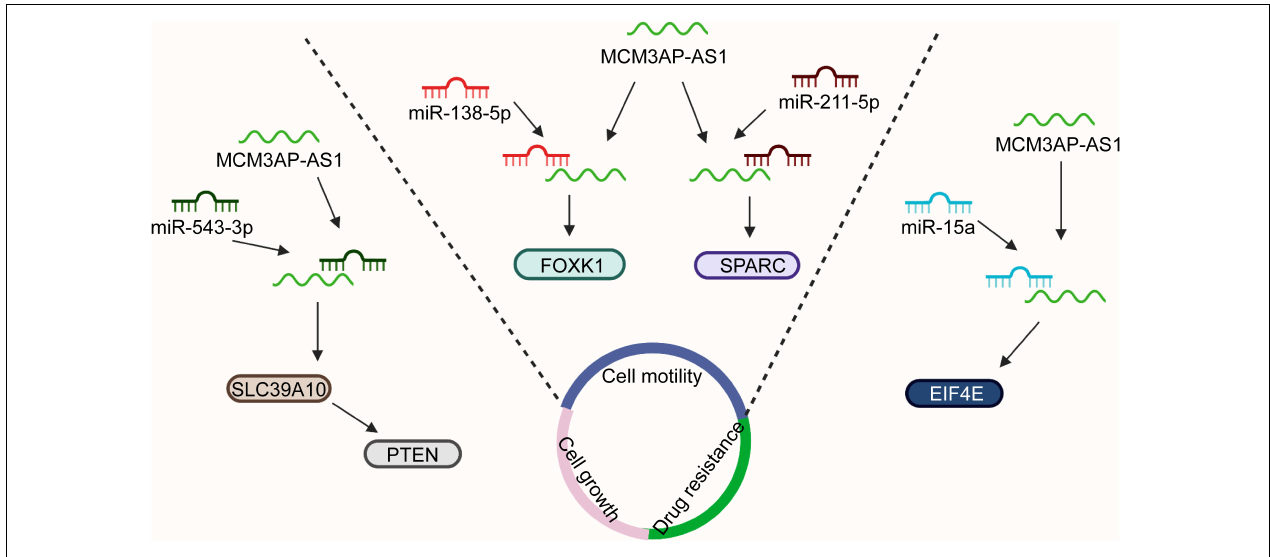
FIGURE 3 | MCM3AP-AS1 functions by interacting with specific molecular pathways. MCM3AP-AS1 enhances cell proliferation via the miR-543-3p/SLC39A10/PTEN axis in PCa. MCM3AP-AS1 reduces the levels of miR-138-5p and increases the expression of FOXK1 to promote cell migration in pancreatic cancer. Cell invasion is enhanced by the activation of the miR-211-5p/SPARC pathway in papillary thyroid cancer. MCM3AP-AS1 regulates the sensitivity of lymphoma cells to doxorubicin by regulating the miR-15a/EIF4E